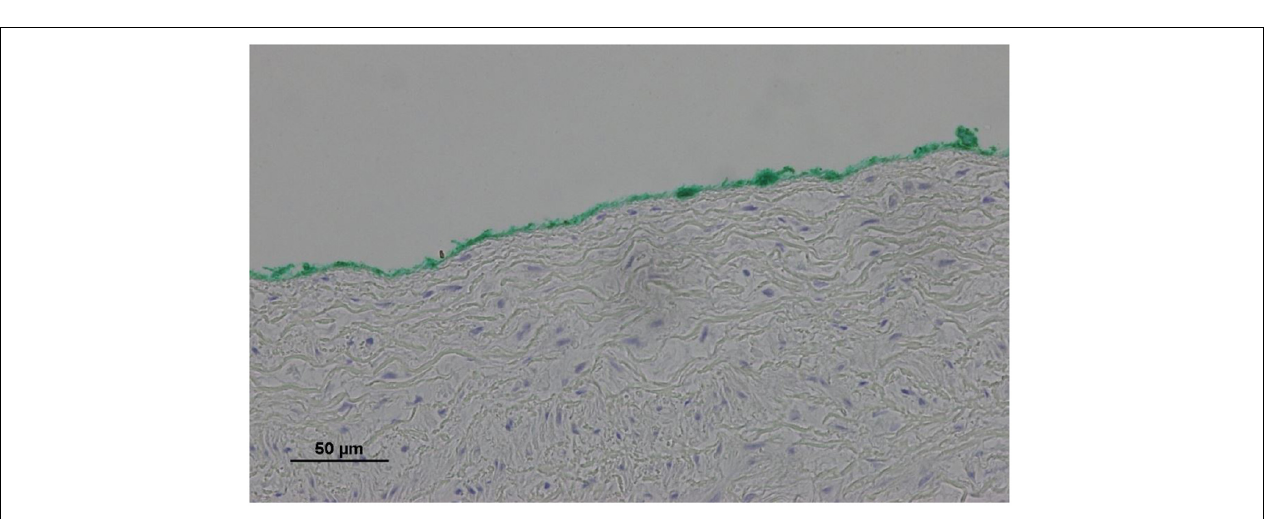
FIGURE 3 | Electron microscopy view of the luminal aspect of the blood vessels at a control site (away from the AHS). Intact endothelial cells are seen.